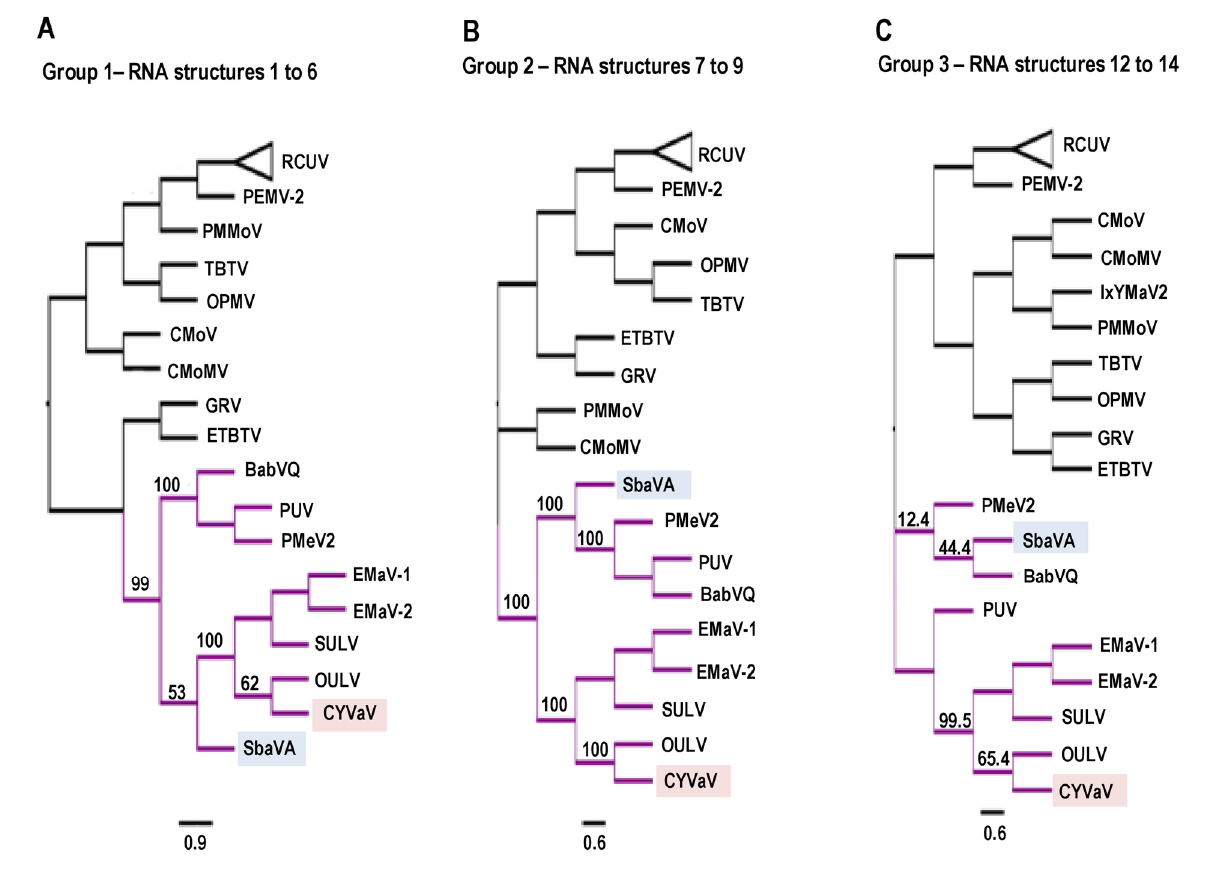
Figure 13. Cladograms of maximum likelihood trees based on the nucleotide sequence of umbravirus and ulaRNA regions. ( A ) Group 1: RNA structures 1–6. ( B ) Group 2: RNA structures 7–9. ( C ) Group 3: RNA structures 12–14 (see Figure 4). The above branch numbers indicate bootstrap support in percentage out of 1000 replicates. All the trees were mid-point rooted. See legend to Figure 2 for abbreviations.